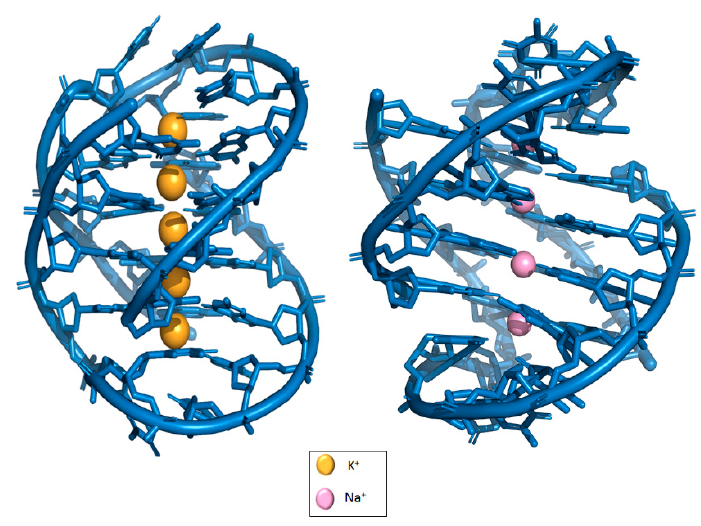
Figure 5. Location of K + (PDB: IJPG) and Na + (PDB: IJB7) in G-quadruplexes.